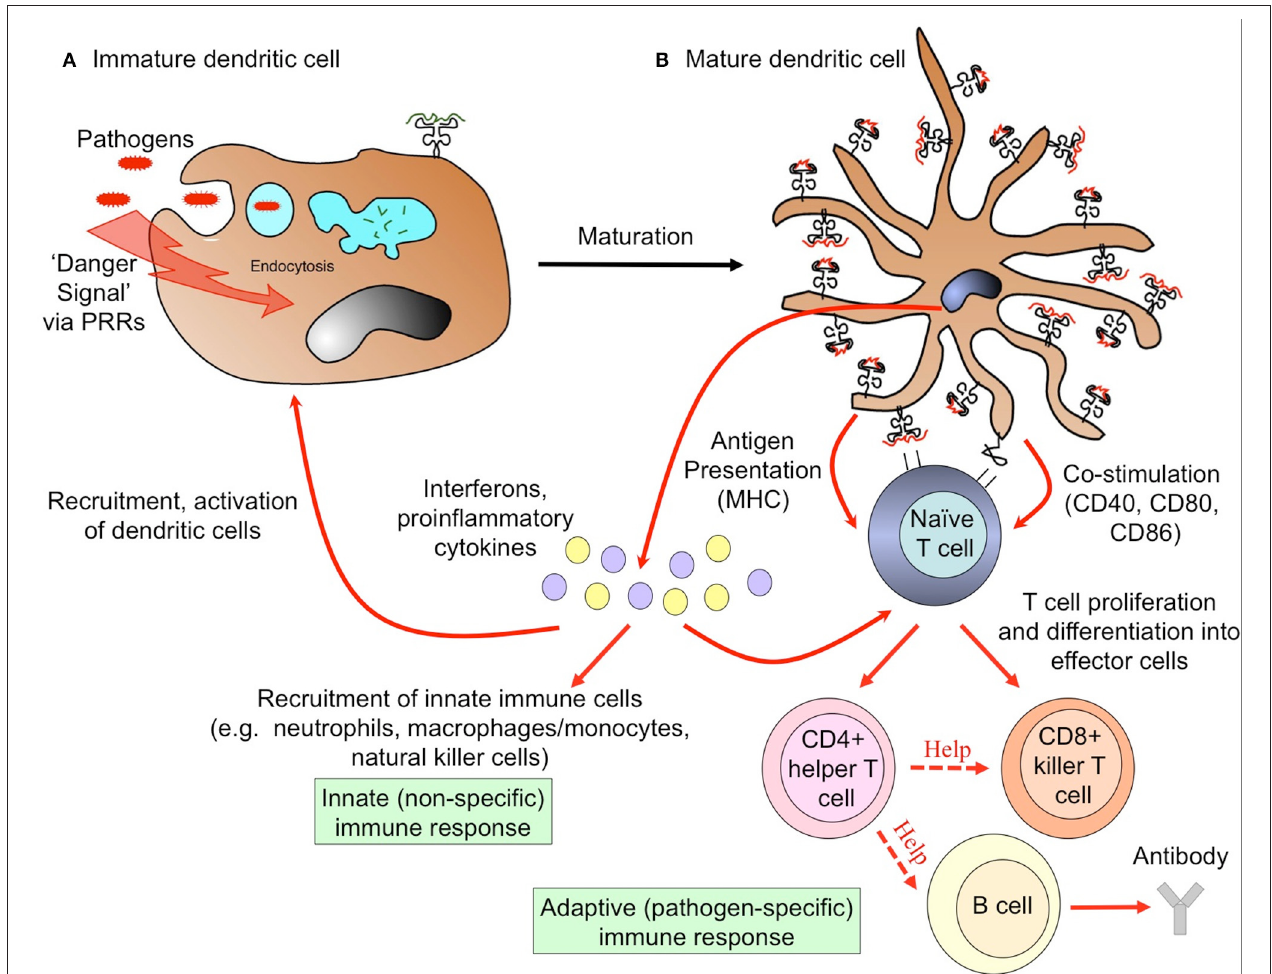
FIGURE 2 | Dendritic cells link innate and adaptive arms of the immune system. (A) Uptake of pathogens and recognition of pathogen-associated “danger signals” by pattern recognition receptors (PRRs) triggers dramatic morphological and functional changes in DCs, termed maturation. These changes involve the formation of dendrites, down-regulation of antigen uptake, and redistribution of major histocompatibility complex (MHC) molecules from intracellular endocytic compartments to the cell surface. (B) Mature DCs migrate to draining lymph nodes and present information about the invading pathogen in the form of processed peptides loaded onto MHC molecules to naïve T cells. Upregulation of MHC and co-stimulation molecules enables activated DCs to initiate adaptive T and B cell immune responses, the nature of which are determined by the cytokine milieu. This initiates the cascade to an adaptive immune response, leading to clearance of infected cells, and extracellular pathogens. Activated mature DCs also secrete interferons and proinflammatory cytokines that recruit circulating innate immune cells to provide rapid defense against